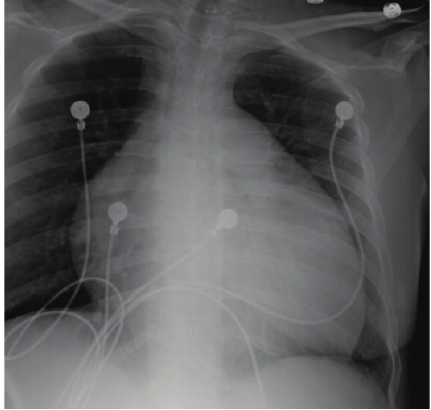
Figure 1: Chest X-ray image showing a significantly enlarged cardiac silhouette.